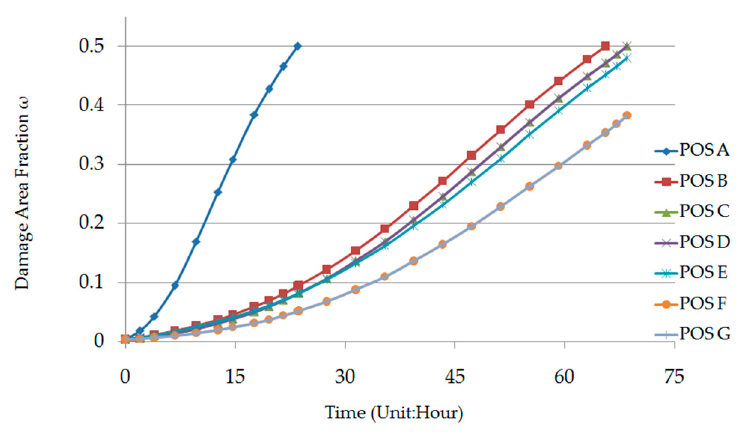
Figure 15. Damage evolution with time of the first seven failed grain boundary elements.